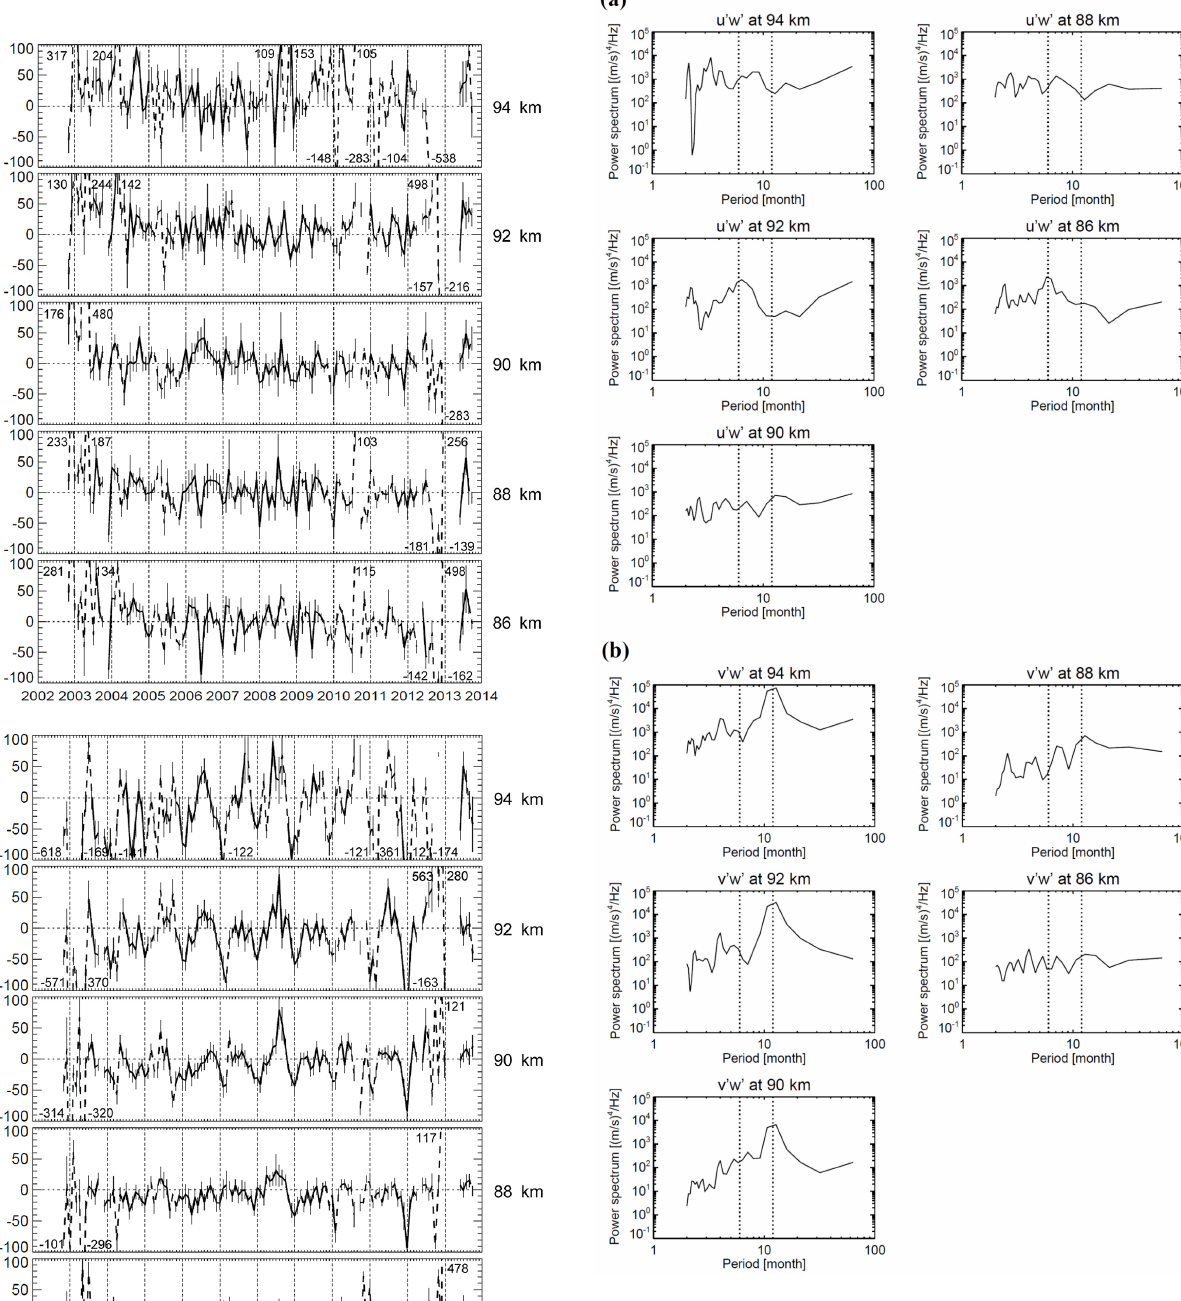
Figure 3. Power spectrum of (a) u (cid:48) w (cid:48) and (b) v (cid:48) w (cid:48) at 86–94km al- titudes at Koto Tabang. The two dashed lines in each panel indicate periodicity of 6 and 12 months,